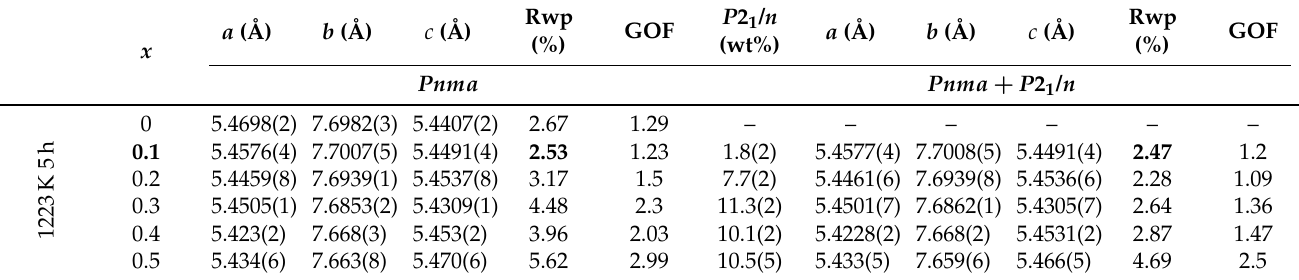
Table A3. Results of Rietveld refinements of Pr 1– x Sr x (Cr,Mn,Fe,Co,Ni)O 3– δ ( x = 0–0.5) after different heating treatments. As an initial point of the refinement, the PrCrO 3 ( Pnma , ICSD 251098) and SrCrO 4 ( P 2 1 / n , ICSD 40922) structures were used. The bold numbers highlight the smallest x value, from which the samples are not considered as pure phase ( Pnma ) any more, as reflected by their corresponding Rwp values. It is clear that with higher heating temperatures, the maximum x value in the pure phase of Pr 1– x Sr x (Cr,Mn,Fe,Co,Ni)O 3– δ is